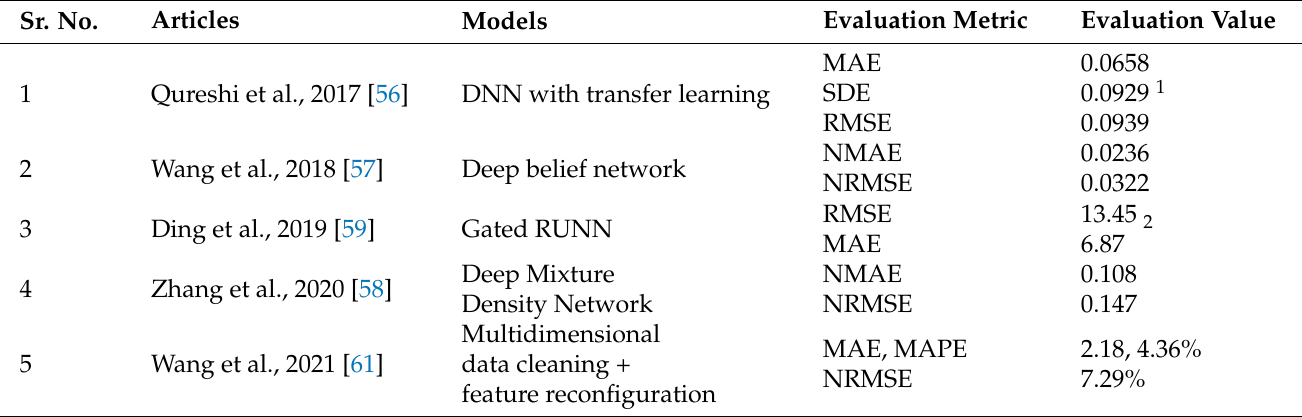
Table 7. Deep learning methods for short-term